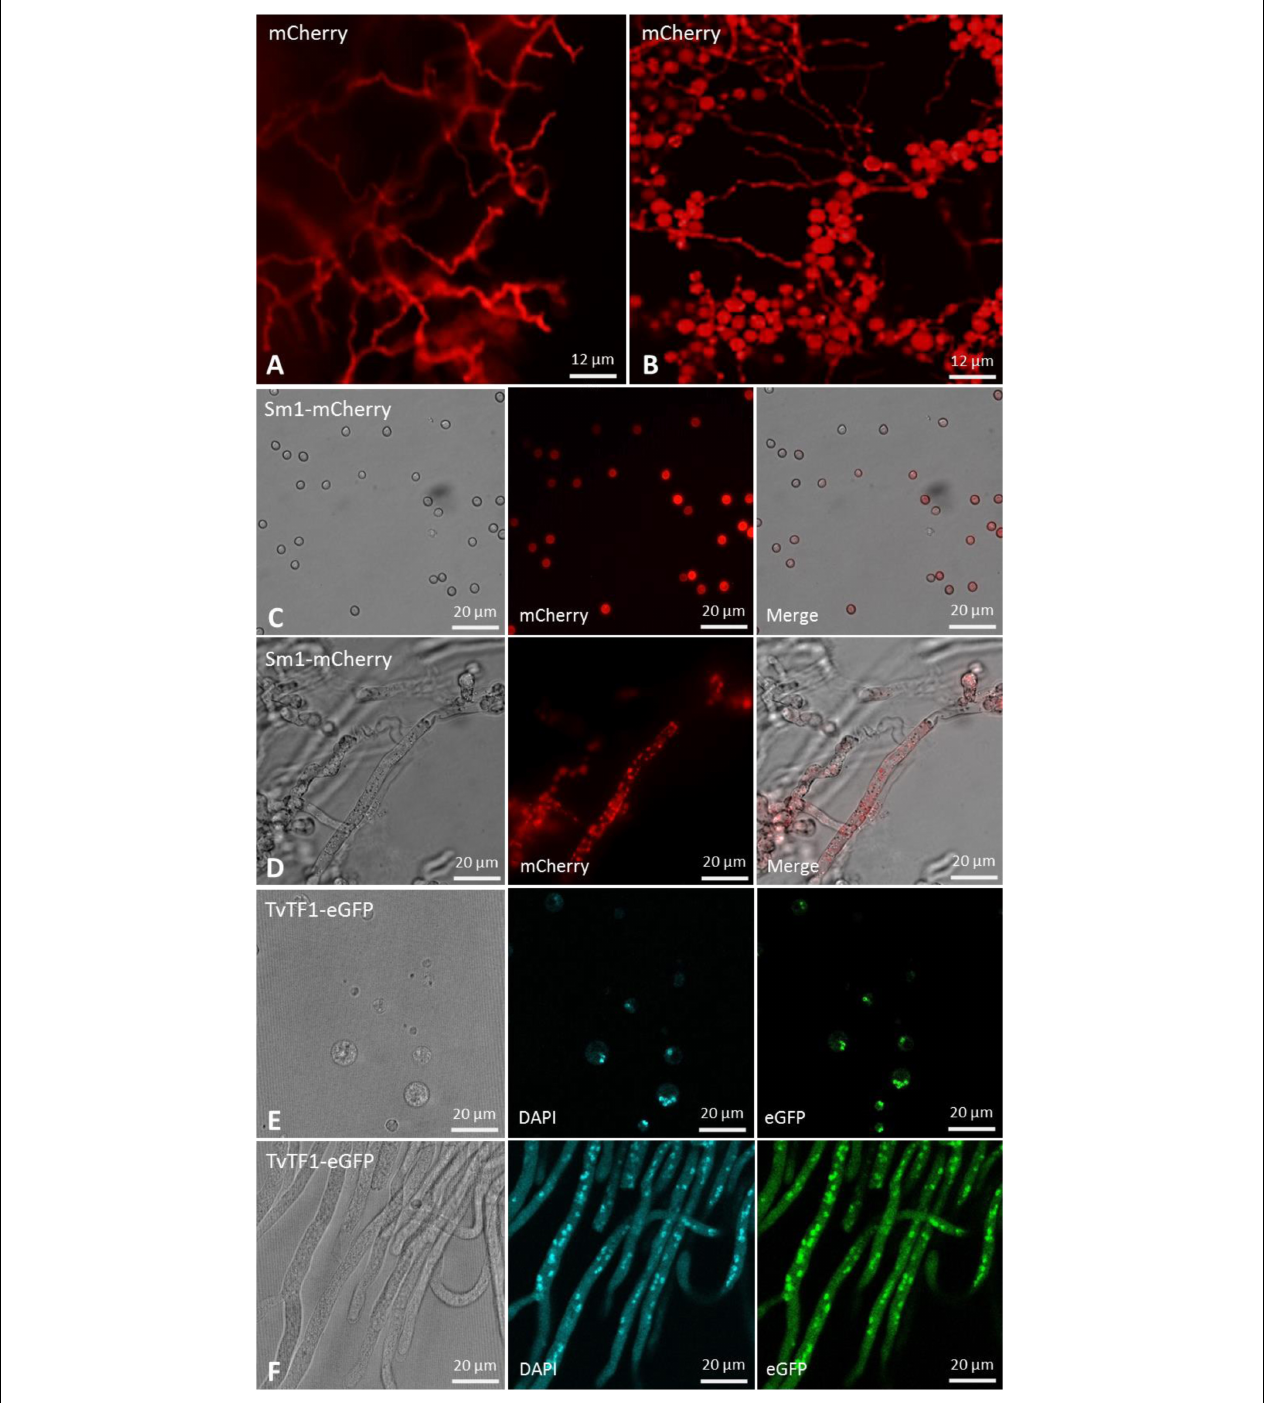
FIGURE 5 | Microscopic observation of the T. virens mutants transformed with a fluorescent marker or protein localization vector generated through the TrichoGate system. Fluorescent microscopy of T. virens mycelia and conidia to verify the expression of the mCherry fluorescent marker under the control of the glyceraldehyde 3-phosphate dehydrogenase ( gpdh ) promoter from T. virens . Red fluorescence corresponding to the mCherry marker observed in T. virens (A) mycelia and (B) conidia. Microscopic observation of the Sm1-linker-mCherry expressed in T. virens (C) conidia and (D) mycelia; left bright-field, middle fluorescence and right merged images. Microscopic observation of the TvTF1-linker-eGFP expressed in T. virens (E) protoplasts and (F) mycelia; left bright-field and right fluorescence images. To visualize mCherry, 587 nm of excitation and 610 nm emission were used; while for the eGFP 484 nm excitation and 507 nm emission were used. No autofluorescence was observed in T. virens mycelia and conidia using either red or green channels. were visualized using an Olympus BX51 compound microscope. Images were captured using an Olympus DP70 digital camera system and processed with the CellSens software (Olympus).